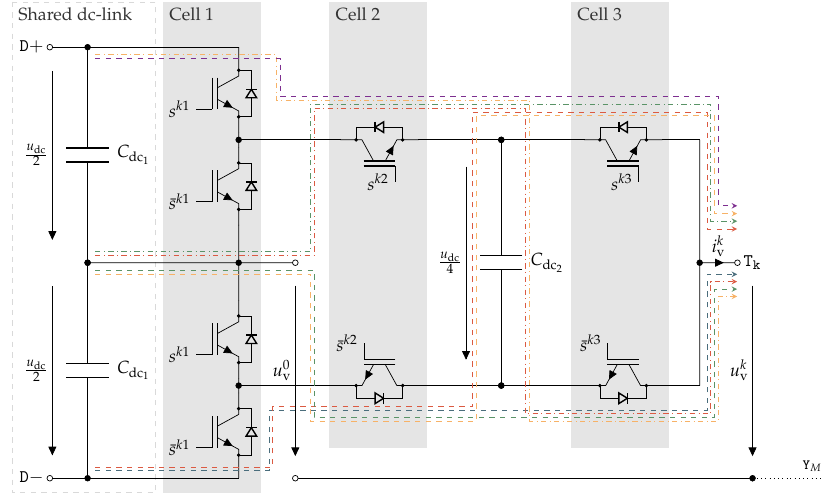
of a 5-level active neutral point clamped a , b , c ∈ { }